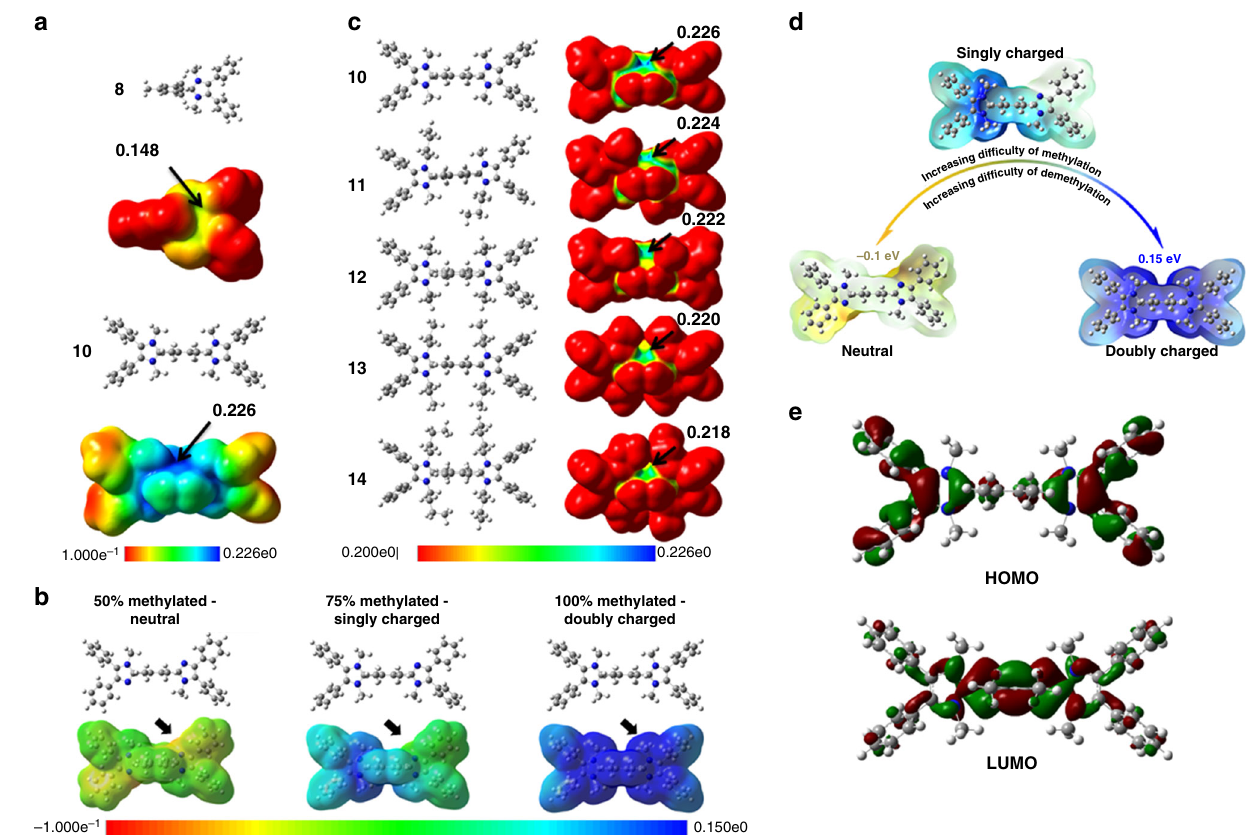
Fig. 3 DFT analyses of imidazoliums. a Electrostatic potentials (ESP) of 8 and 10 (potential bar 0.1 to 0.226 eV); b dimethylated (neutral), trimethylated (singly charged), and tetramethylated (doubly charged) imidazole (or imidazolium) (potential bar − 0.1 to 0.15 eV underneath); c ESP of 10 – 14 (potential bar 0.2 – 0.226 eV). d Methylated or demethylated scheme of compound 10 . e HOMO and LUMO orbitals of